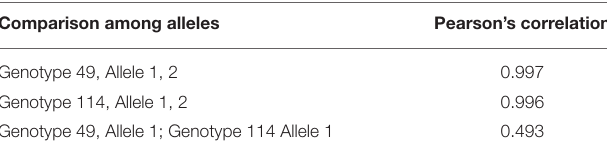
TABLE 1 | Pearson’s correlations among alleles of the Chakwal-50 replicates (IDs 49 and 114) using GBS data. Comparison among